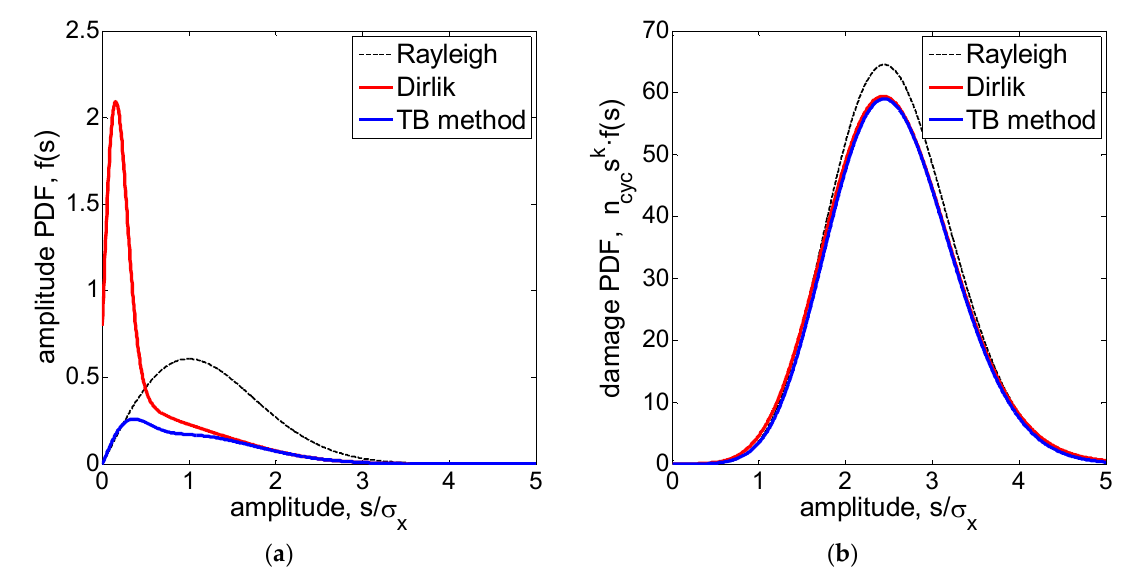
Figure 6. Comparison of ( a ) rainflow probability distributions, ( b ) weighted by the damage per amplitude. The figures refer to parameters r f = 7.408, r A = 0.006 (with α 1 = 0.900, α 2 = 0.300).